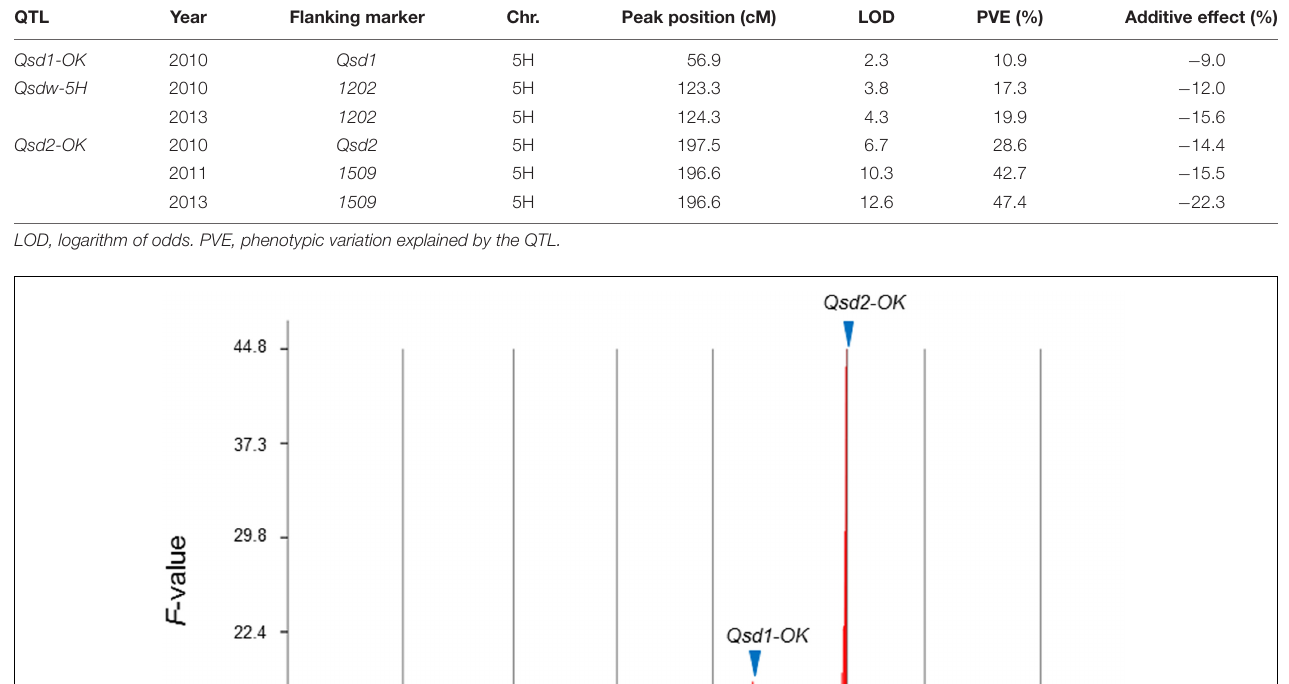
TABLE 1 | Grain dormancy QTL identified by SIM.